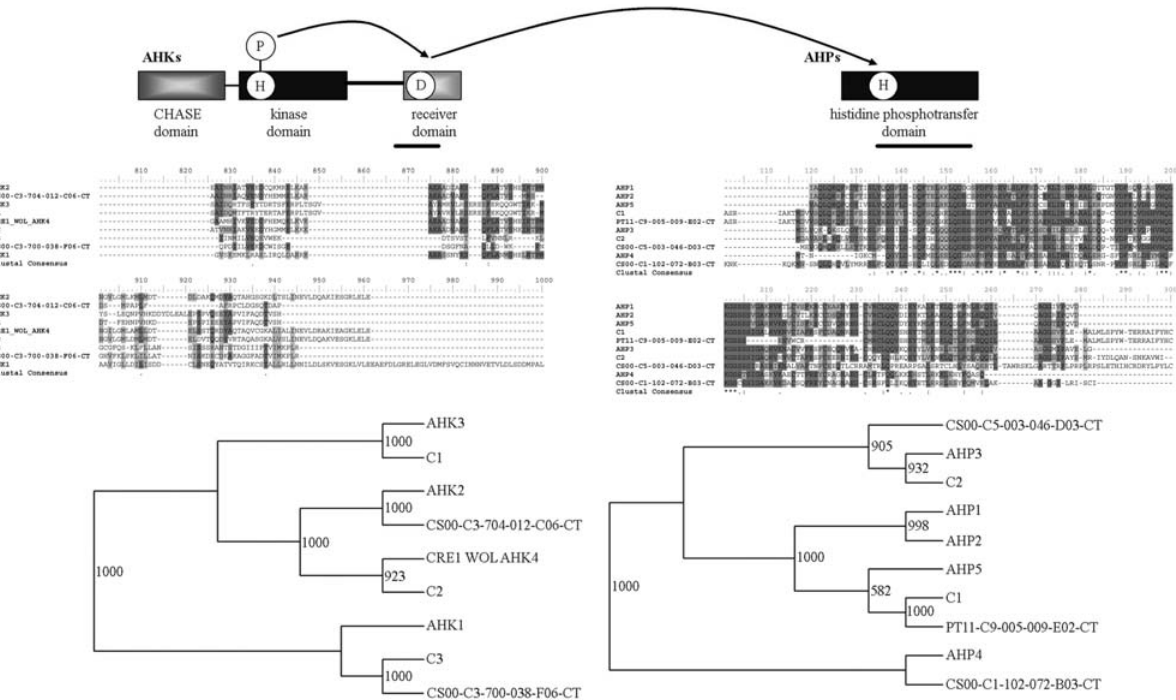
Figure 2 - Cytokinin-mediated signal transduction in citrus. Schematic representation of AHK to AHP phosphorelay. Alignment of the receiver domain from A. thaliana and citrus AHK proteins and phylogenetic analysis of citrus AHKs. Alignment of the conserved histidine phosphotransfer domain from A. thaliana and citrus AHP proteins and phylogenetic analysis of the deduced amino acid sequence of citrus and Arabidopsis full-length proteins. Phylo- genetic analysis was performed using full-length Arabidopsis proteins and the deduced amino acid sequence of citrus transcripts as described. Black and gray shading of amino acid residues represents sequence identity and similarity,